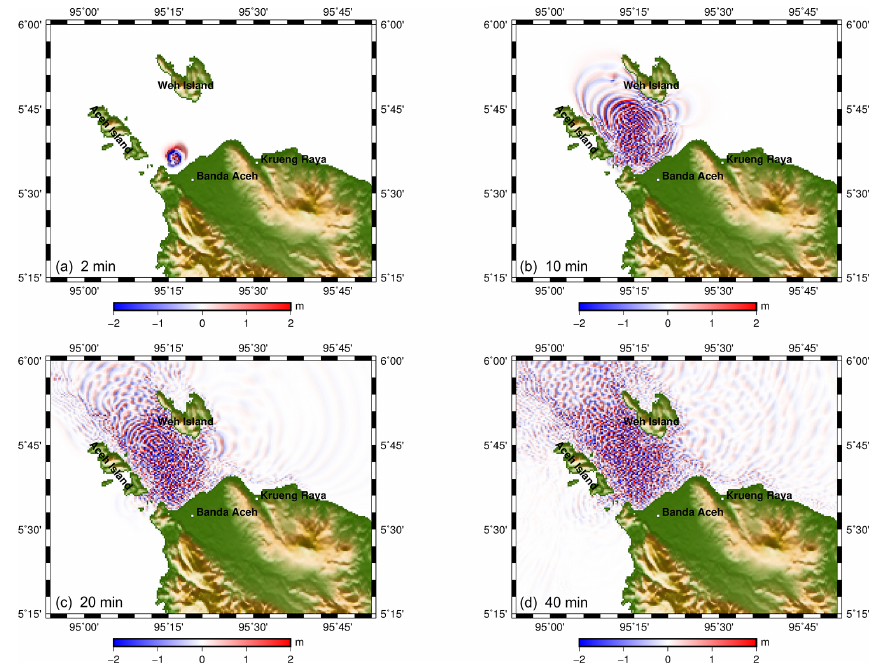
Figure 9. Snapshots of a tsunami wave from a submarine landslide source at location 7 of Fig. 6c at propagation times of (a) 2min, (b) 10min, (c) 20min and (d)